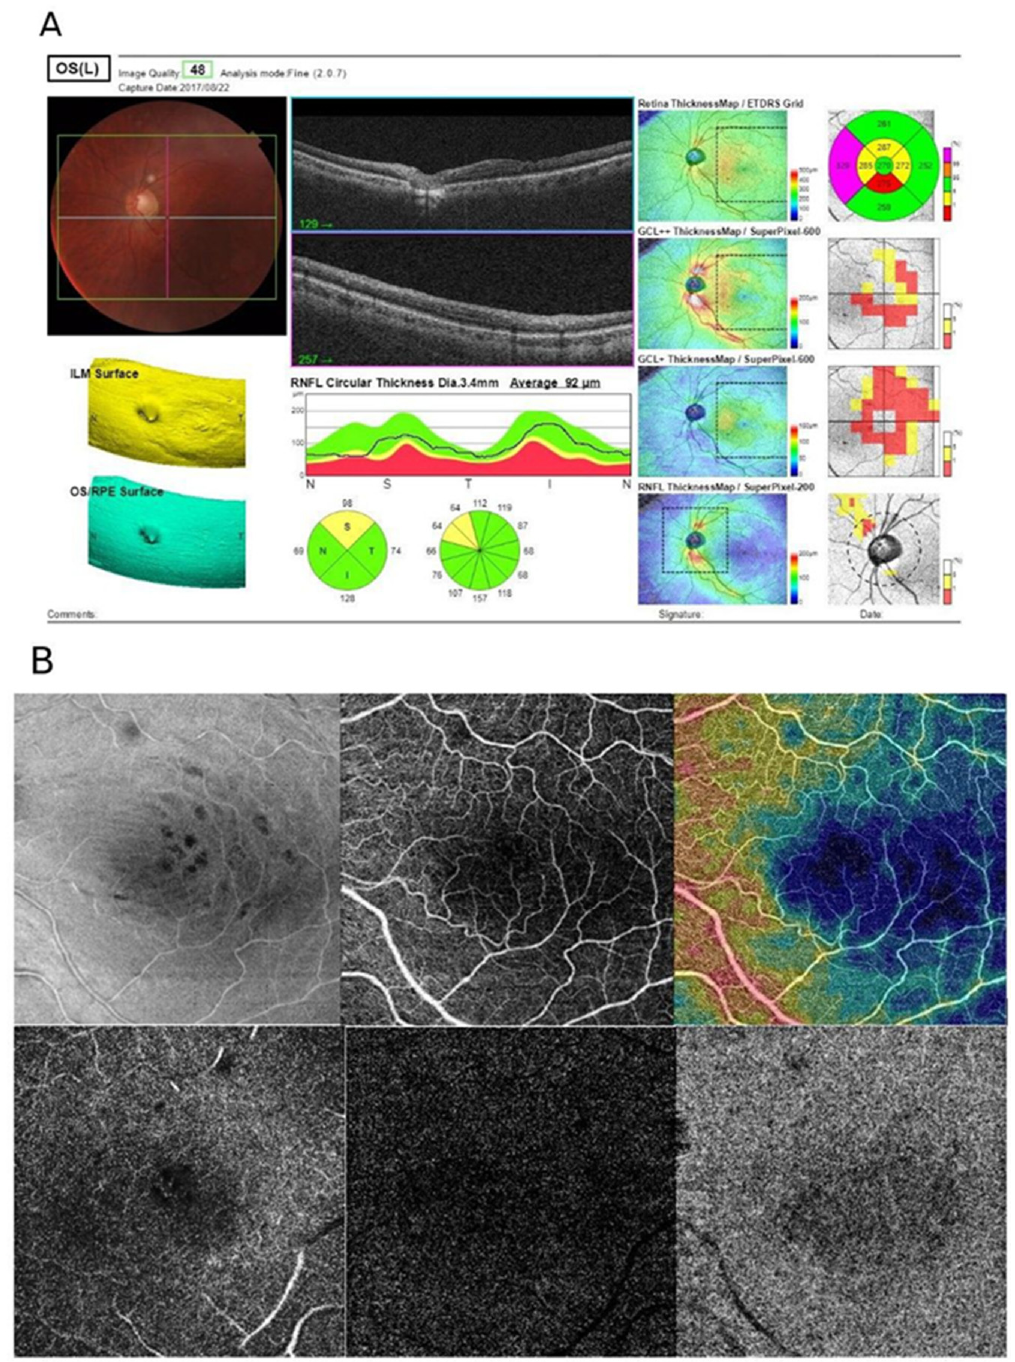
Figure 2. Comprehensive report of a patient who underwent PPV for RRD. ( A ) the OCT-A scans; ( B ) the vascular density map; PPV—pars plana vitrectomy; RRD—rhegmatogenous retinal detach- ment.